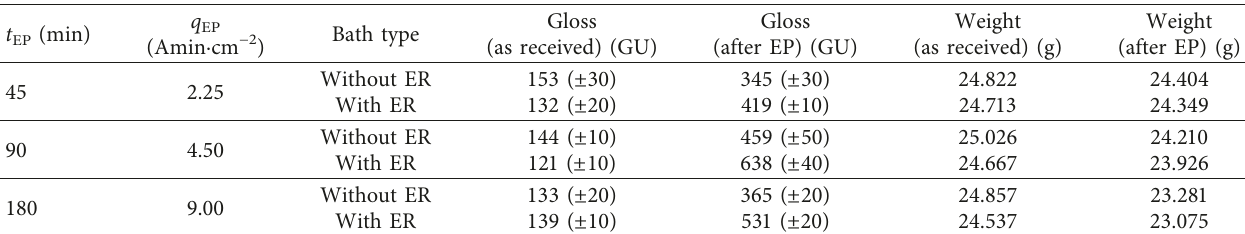
Table 1: Presentation of the gloss and weight of samples “as received” and samples electropolished in a bath without ER and with ER (EP process parameters: t